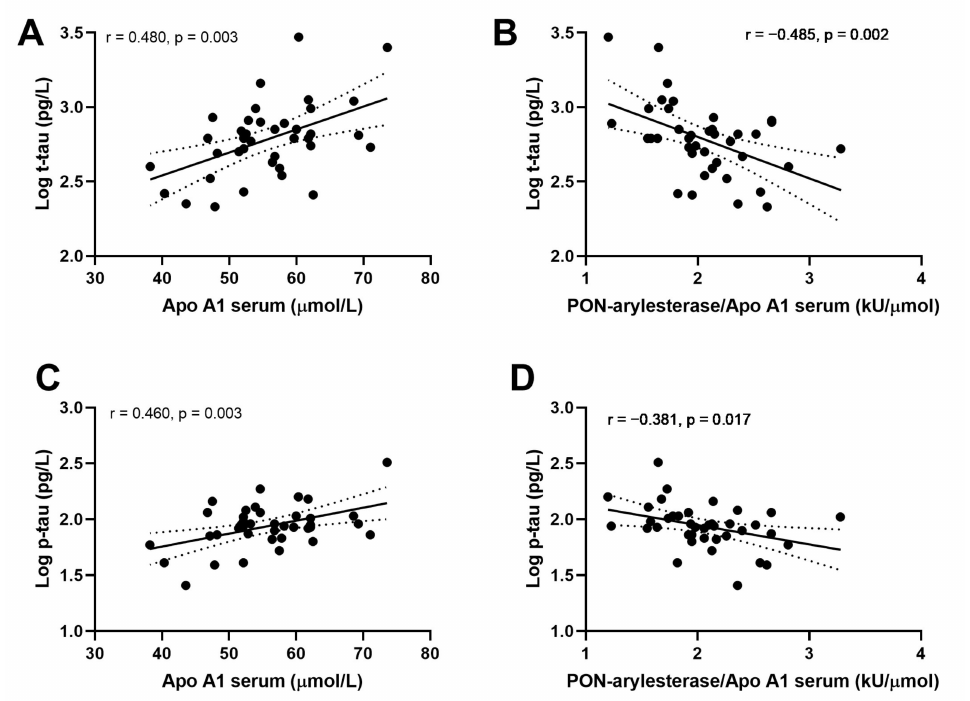
Figure 5. Correlation between serum APO A1 and CSF log t-tau ( A ); serum PON-arylesterase / Apo A1 ratio and CSF log t-tau ( B ); serum APO A1 and CSF log p-tau ( C ); serum PON-arylesterase / Apo A1 ratio and CSF log p-tau ( D ). Pearson’s correlation test was used to test the association between the variables of interest among AD patients of ADC ( n = 39). Abbreviations: ApoA1, apolipoprotein A1; VaD, vascular dementia; AD, Alzheimer’s disease; PON,